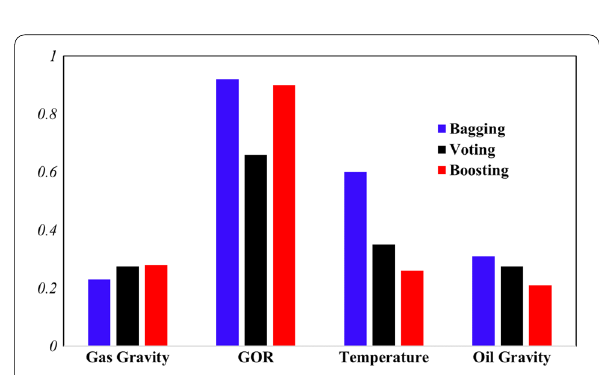
Fig. 28 Sensitivity analysis of the ensemble learners and the oil viscosity